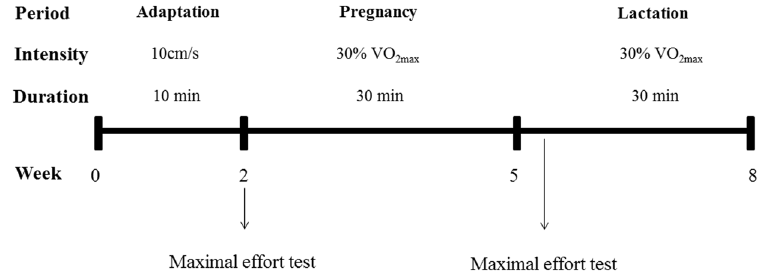
Figure 5. Low intensity physical training program in female rats during pregnancy and lactation periods, according to velocity, duration and intensity of